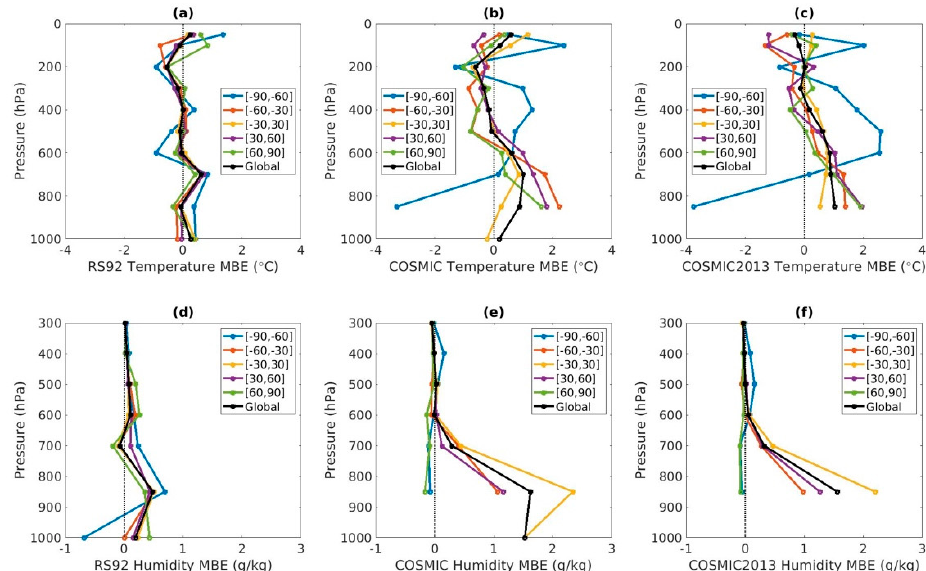
Figure 4. Mean bias errors (MBE) between HIRS and other retrievals (HIRS–other) at standard atmospheric pressure levels, subdivided by latitude ranges. Temperature MBE (°C) for HIRS comparisons with ( a ) radiosonde (RS92); ( b ) constellation observing system for meteorology ionosphere and climate (COSMIC); and ( c ) COSMIC2013. Humidity MBE (g/kg) for comparisons with ( d ) RS92; ( e ) COSMIC; and ( f ) COSMIC2013.